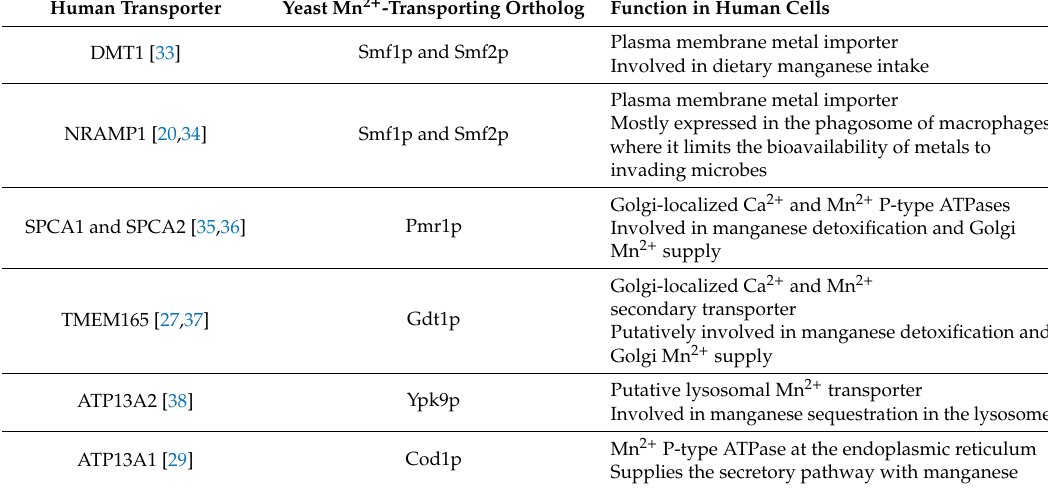
Table 1. Human transporters involved in manganese homeostasis that possess a yeast ortholog. Human